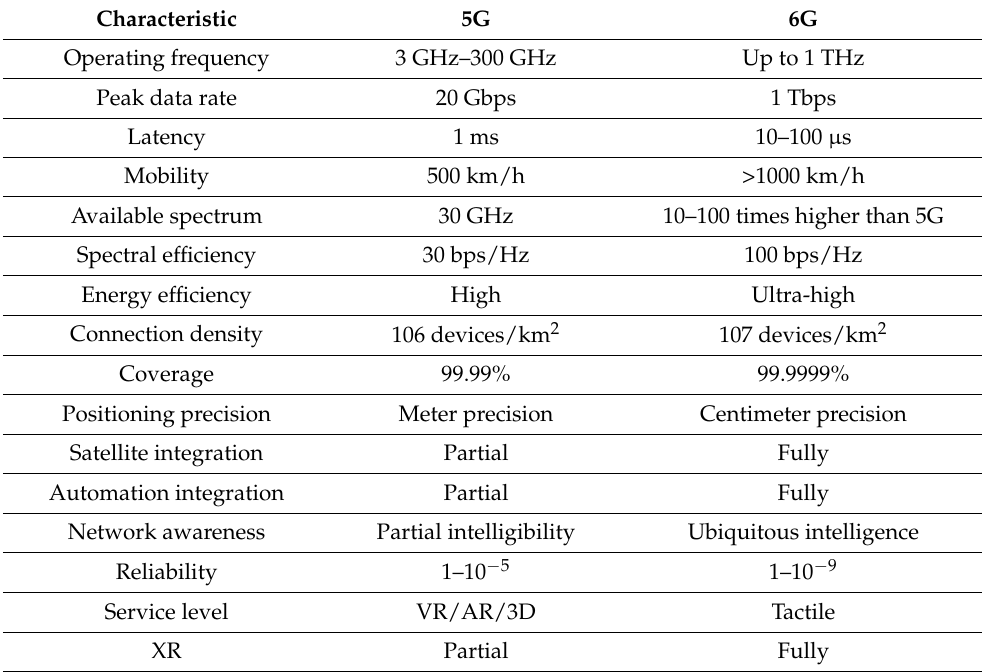
Table 1. Comparison of 5G and 6G communication techniques